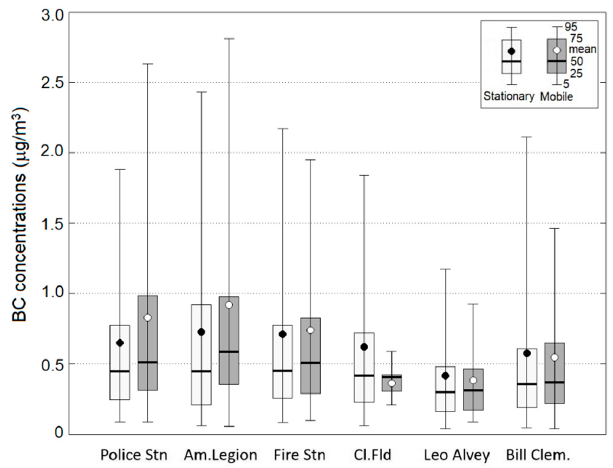
8 of 16 Figure 3. Schematic map of the study area showing mobile monitoring routes and selected sampling areas. The routes are designed to provide spatially resolved pollutant concentration measurements in and around the three communities, as well as six fixed measurement sites in the area as described by Kimbrough et al. [13]. During the Fall 2017 and Spring 2018 monitoring campaigns, the GMAP vehicle was driven continuously along one of five pre-determined routes as shown in Figure 3 (Turner community route, I-635 route, American Legion route, Argentine community route, Armourdale community route). Vehicle battery allowed for approximately 6 to 10 h of continuous sampling each day, allowing for multiple laps per session. Sampling was done for multiple days, with a larger frequency of measurements in the Argentine community to better evaluate emission impacts from the rail yard and maintenance facility. A comparison of distributions of observed BC concentrations at six stationary sites and at